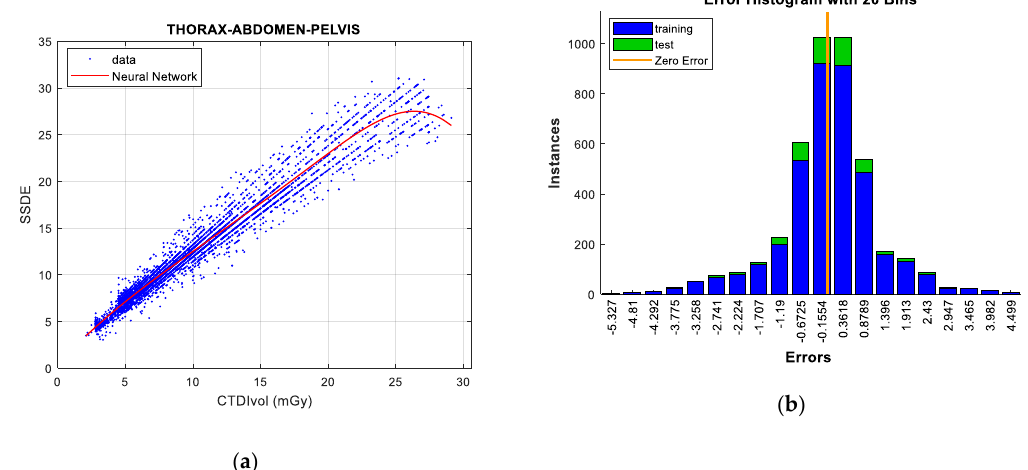
Figure 11. SSDE prediction according to CTDI VOL for Thorax, Abdomen, & Pelvis protocol ( left ), together with error histograms ( right ), employing the Neural Networks technique ( a , b ).